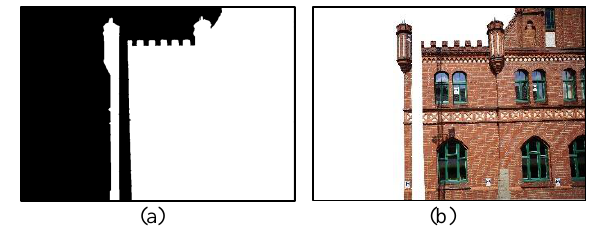
Figure 9. Ground truth for the segmented object.